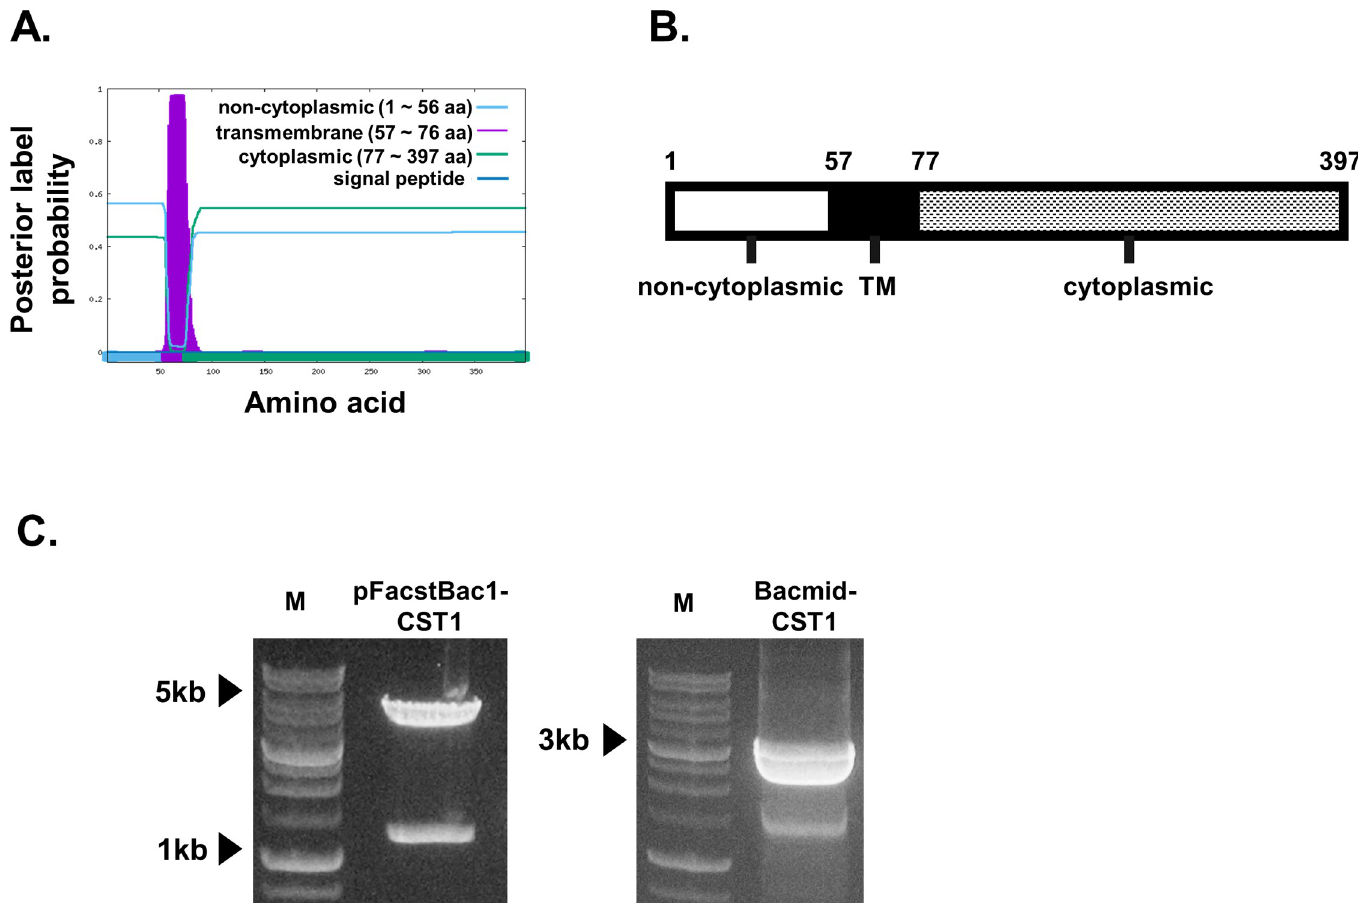
Fig 1. TM prediction, diagram and gene cloning. (A) The transmembrane structure was analyzed by performing an in silico analysis of the CST1 protein amino acid sequence with Phobius. The x-axis represents the position of the amino acid, and the y-axis represents the probability that the amino acid at the corresponding position occupies each region or domain. (B) A schematic diagram depicting the CST1 gene used in this study (positions 1–397) was also provided, with the numbers denoting amino acid positions. (C) Recombinant pFastBac1 vector expressing the CST1 gene was digested with restriction enzymes to confirm CST1 gene integration (left panel). Colony PCR was performed to confirm the successful transposition of the CST1 gene into the bacmid DNA (right panel).